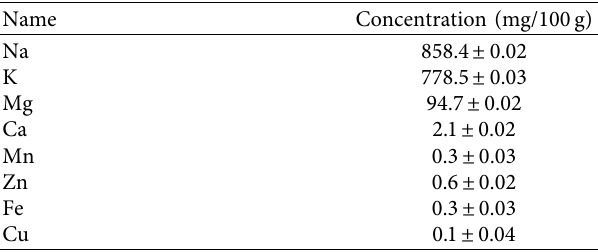
Figure 2: Essential amino acids (EAA), semiessential amino acids (SEAA), and nonessential amino acids (nEAA) of tunichrome released from Phallusia nigra Persian Gulf marine tunicate. Table 2: Na, K, Mg, Ca, Mn, Zn, Fe, and Cu contents of tunichrome released from Phallusia nigra Persian Gulf marine tunicate.